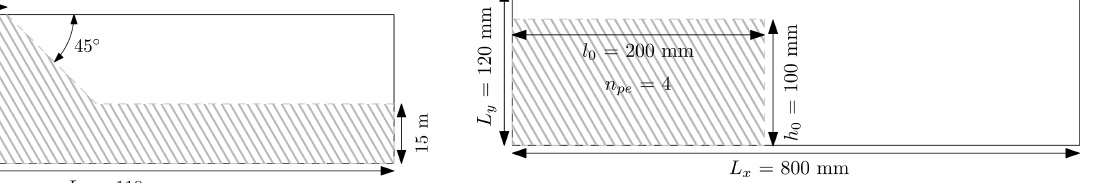
Figure 16. Initial geometry for the elasto-plastic collapse (Huang et al., 2015). Roller boundaries are imposed on the left and right boundaries of the computational domain, while a no-slip condition is enforced at the bottom of the domain. The aluminium-bar as- semblage has dimensions of l 0 × h 0 and is discretized by n pe = 4 material points per initially populated